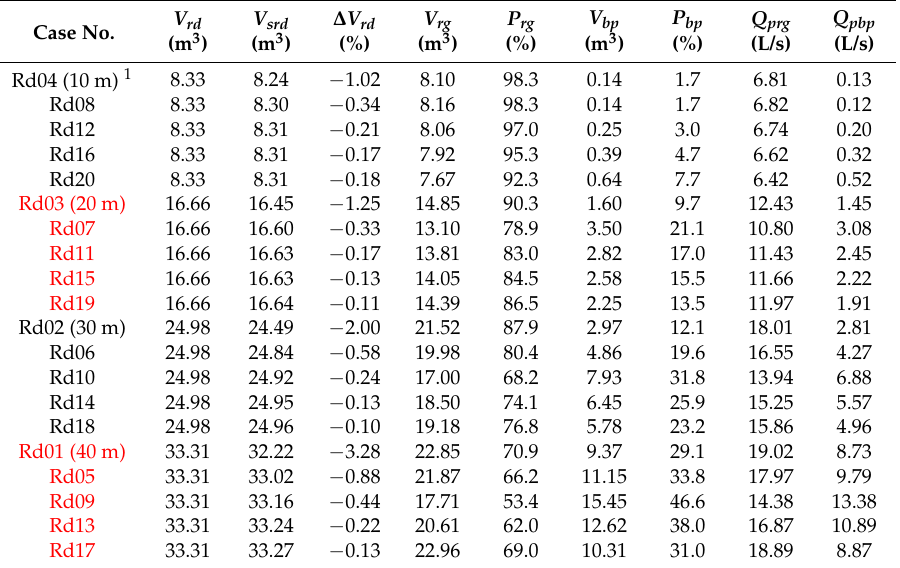
Table 4. Summary of simulation results of 20 road-only modeling cases (grouped by L ).